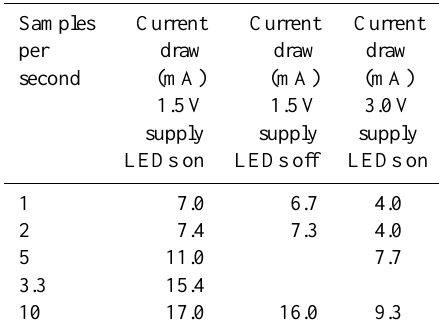
Table 1. B1100-1 Current consumption for one fresh alkaline cell and two cells in series. Samples Current Current